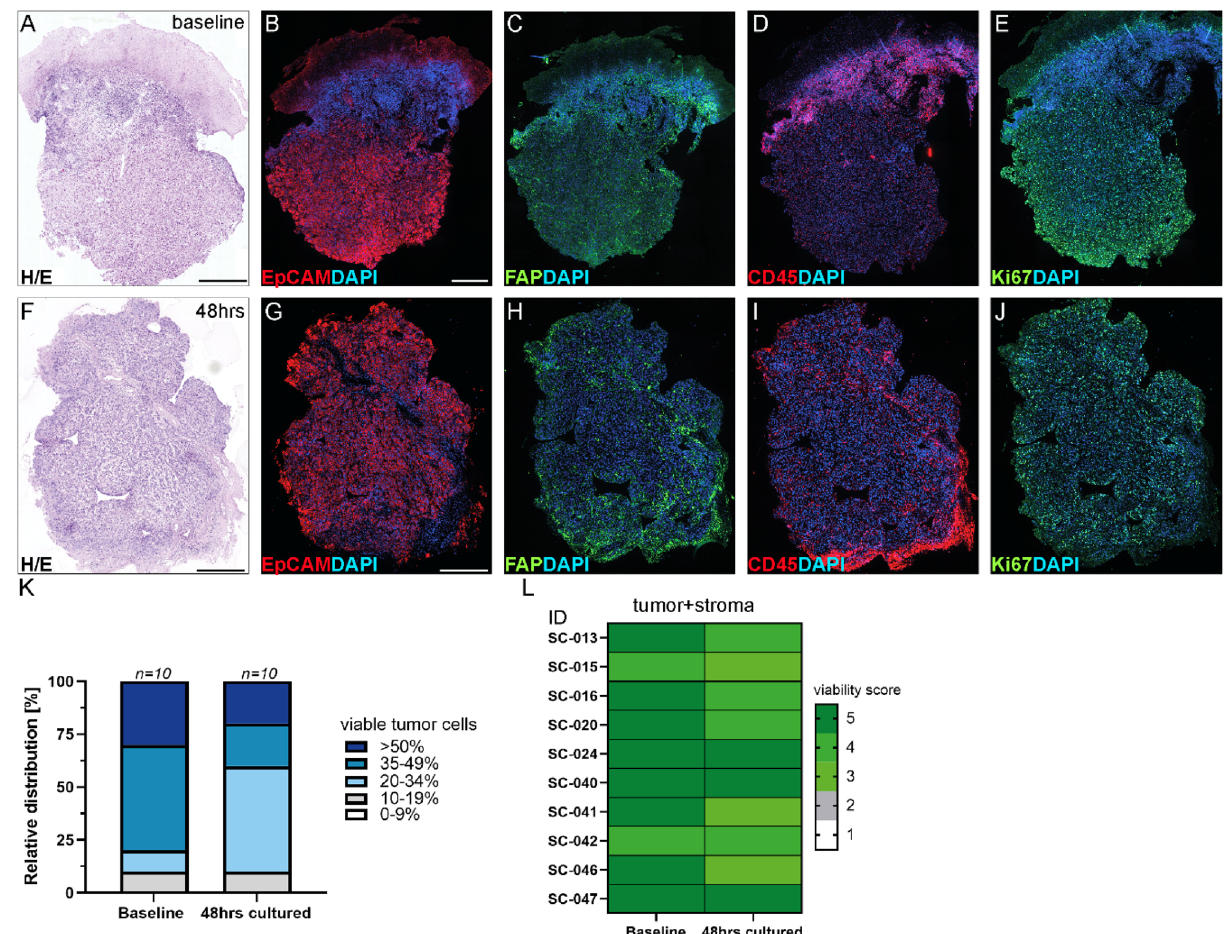
Figure 2. Patient-derived HNSCC slice cultures retain tissue composition ex vivo. ( A , F ) Morphology of baseline (0 h) and ALI cultured (48 h) HNSCC slices (SC-024) was assessed (H/E). Immunofluorescent stainings were performed on baseline ( B – E ) and 48 h cultures ( G – J ) to analyze the presence of the tumor tissue ( B , G ) (EpCAM-red), the stromal compartment ( C , H ) (FAP-green) and the immune compartment ( D , I ) (CD45-red). Proliferation was assessed in baseline and 48 h cultures ( E , J ) (Ki67-green). DAPI (blue) was used as nuclear counterstain. Scale bars represent 200 µm. ( K , L ) Relative distribution and viability of baseline and cultured patient derived HNSCC slices was determined via digital pathology (n = 10 HNSCCs). ( K ) Graph depicts relative distribution according to percentages of viable tumor cells. ( L ) A 5-tiered scoring system was used to classify the percentage of viable cells within the tumor and stroma: 1 for less than 10%, 2 for 10–34%, 3 for 35–50%, 4 for 51–80% and 5 for more than 80%. Cultured and respective baseline specimens displayed a viability score ranging from